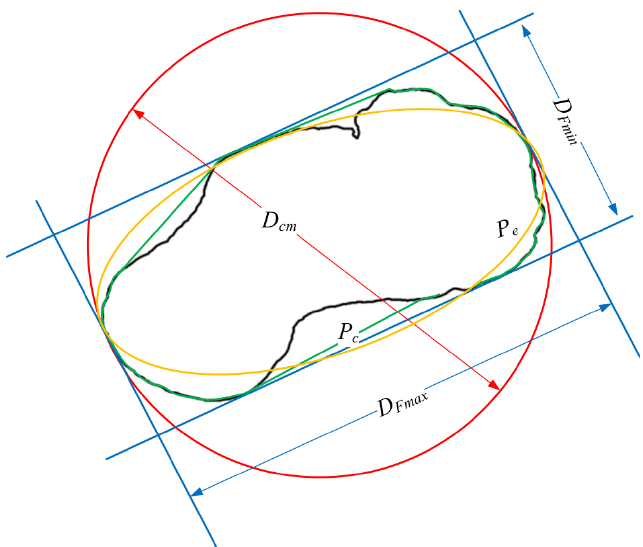
Figure 4. Particle fundamental dimensions analysis of a representative